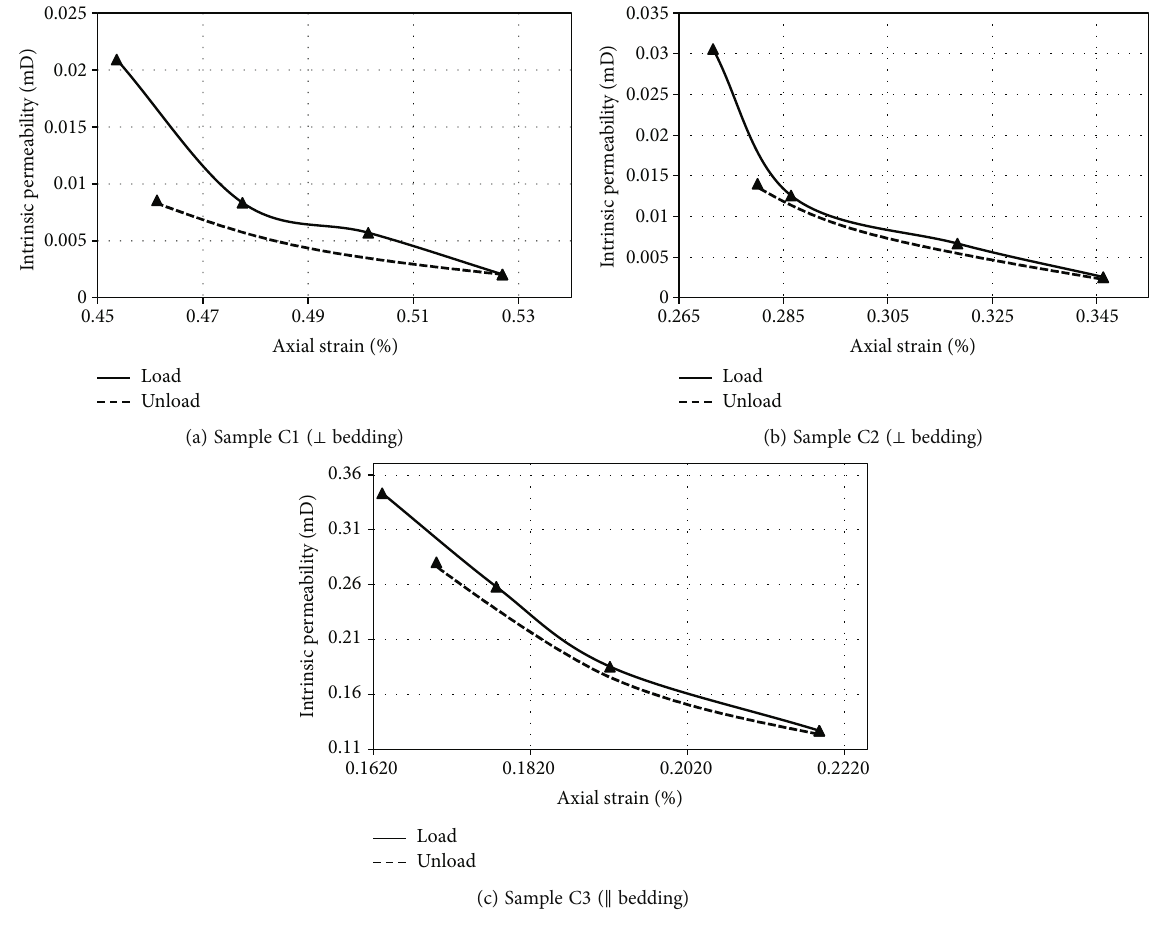
Figure 5: Intrinsic permeability changes with strain during cyclic loading.